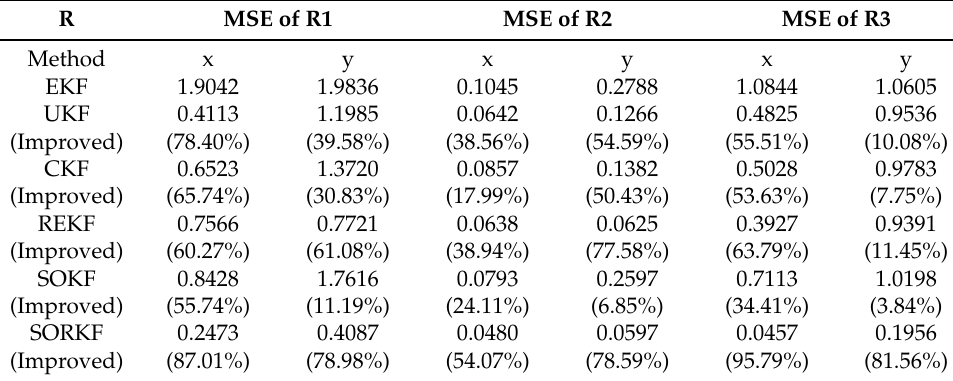
Table 1. MSE for multi-robot trajectory estimation in fixed formation.